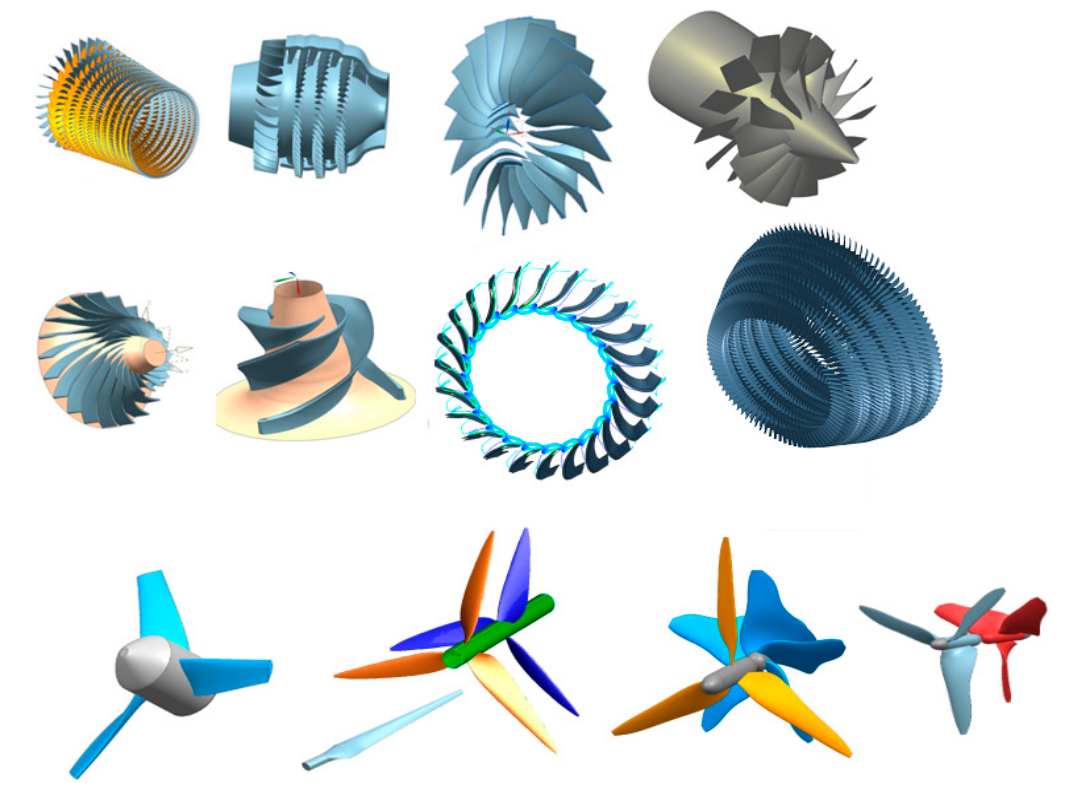
Figure 15. General capability of the tool showing ducted and unducted rotors.